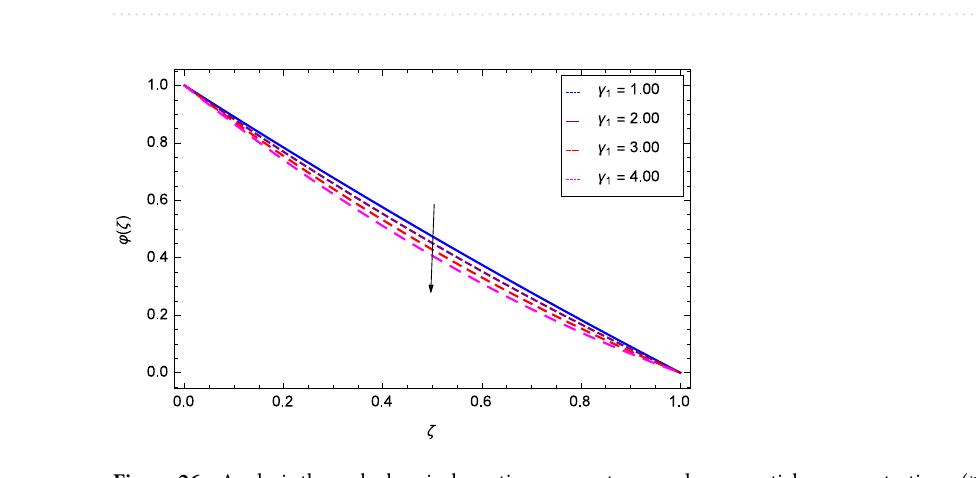
Figure 25. Analysis through Arrhenius activation energy parameter E and nanoparticles concentration ϕ ( ζ ).